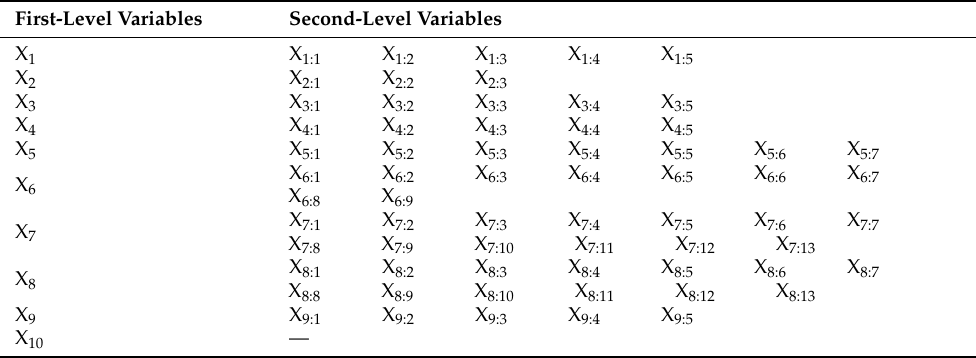
Table 4. Input-output table.